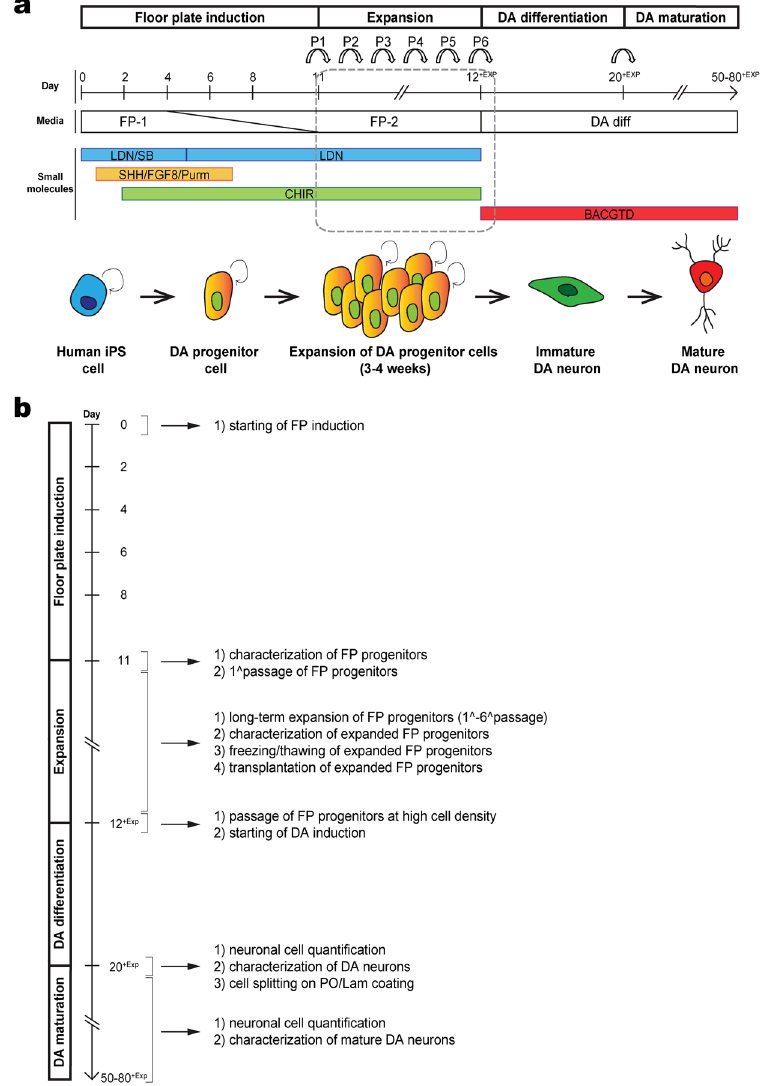
Figure 1. Schematic diagram for efficient expansion of in vitro DA neuron progenitors and final DA neuron maturation from human iPSCs. ( a ) In vitro DA neurons were generated using a standard mFFP protocol 11 with some modifications. After 11 days of neuralisation and floor plate induction by adding signaling molecules such as SHH, FGF8 and CHIR-99021, mFPPs were amplified by cell passaging and maintained in culture for 3–4 weeks (6 passages in total as indicated by the arrows P1–P6). During progenitor expansion, cells were maintained into LDN-193189 and CHIR-99021. After cell expansion, differentiation of mFPPs into mature and functional DA neurons was induced up to day 50–80 (from day 12 + EXP to day 50–80 + EXP ). ( b ) Flow diagram of mFPP expansion and DA neuron differentiation with description of the most important steps and possible applications. FP-1, floor plate induction medium n.1; FP-2, floor plate expansion medium n.2; DA diff, DA differentiation medium; LDN, LDN-193189; SB, SB431542; Purm, Purmorphamine; CHIR, CHIR-99021; BACGTD, BDNF, ascorbic acid, cAMP, GDNF, TGF- β 3,